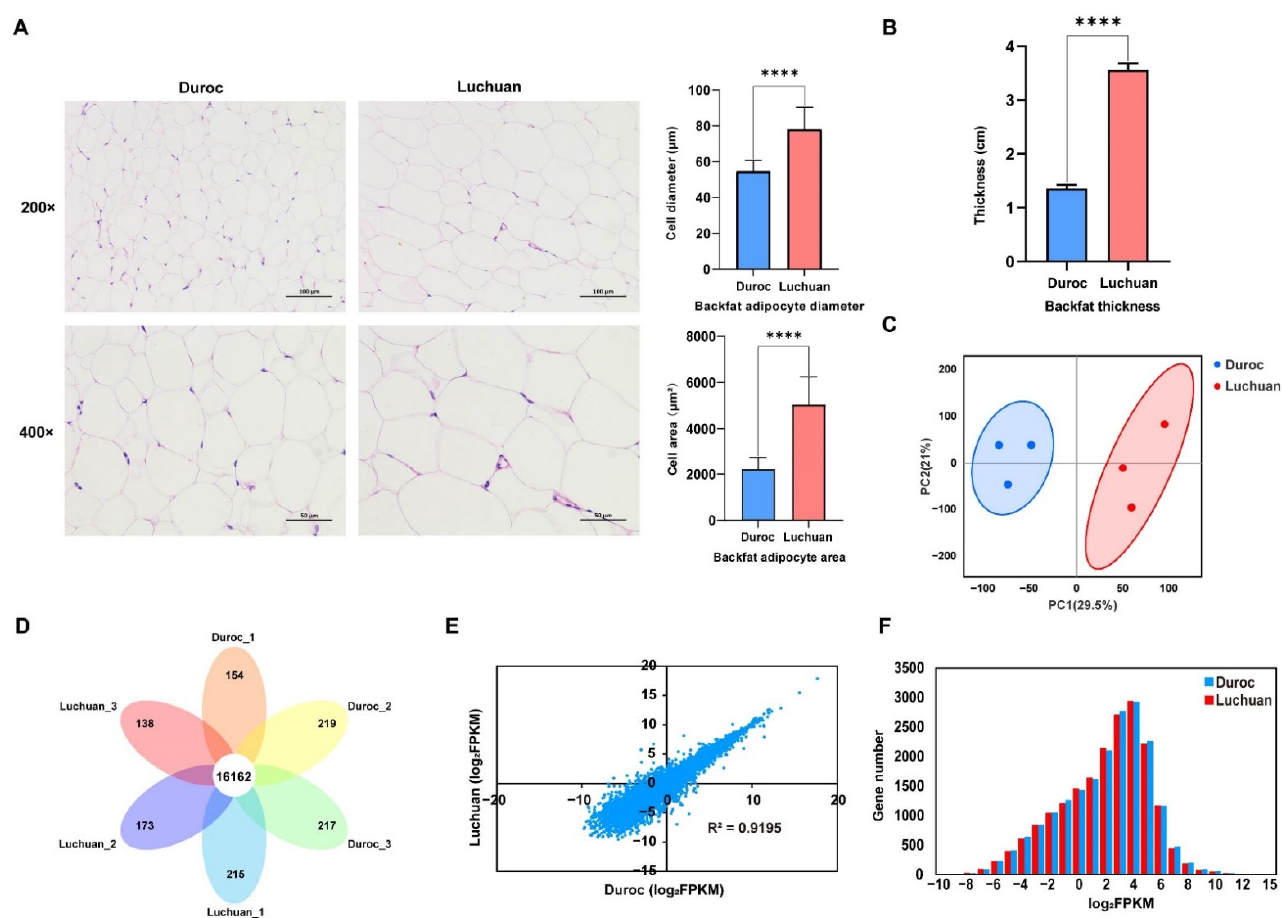
Figure 1. Phenotype and characteristics of RNA ‐ seq data. ( A ) Adipose tissue sections at 200× and 400× magnification. Quantification of the diameter and area of adipocytes. ( B ) Backfat thickness of Duroc and Luchuan. ( C ) PCA of samples. ( D ) The petal Venn diagram of the gene identified by RNA ‐ seq. ( E ) Expression abundance correlation analysis between Duroc and Luchuan in RNA ‐ seq. ( F ) Distribution of the mRNA abundance. The data are expressed as mean ± SD. **** p < 0.0001.